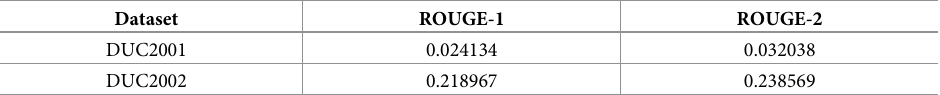
Table 10. The p-values obtained by Approach-1 (WMD) with SOM and without SOM based operators (under SMaxRouge scheme) considering ROUGE-1 and ROUGE-2 score values. Dataset